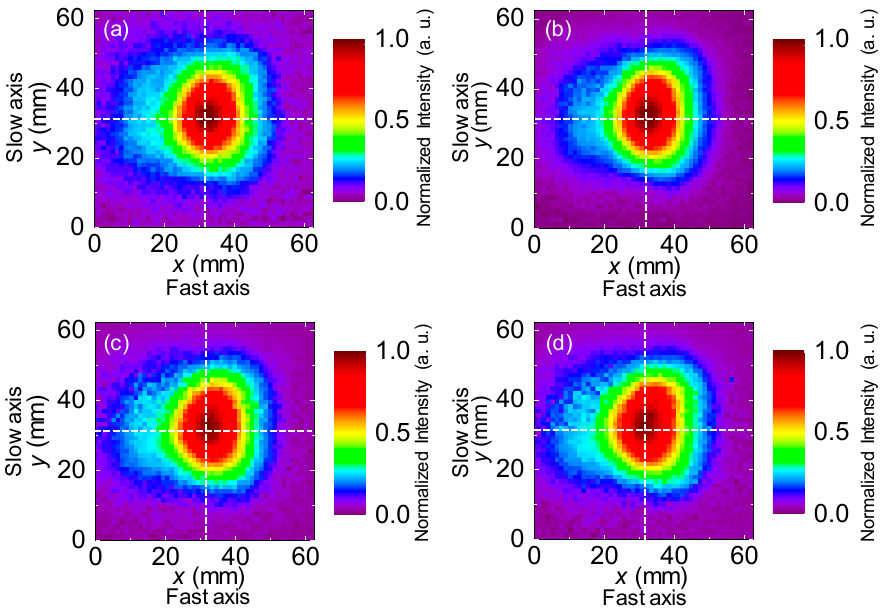
Figure 3. Far-field profiles from THz NL-QCL at: ( a ) 297 K, ( b ) 240 K, ( c ) 200 K and ( d ) 160 K.